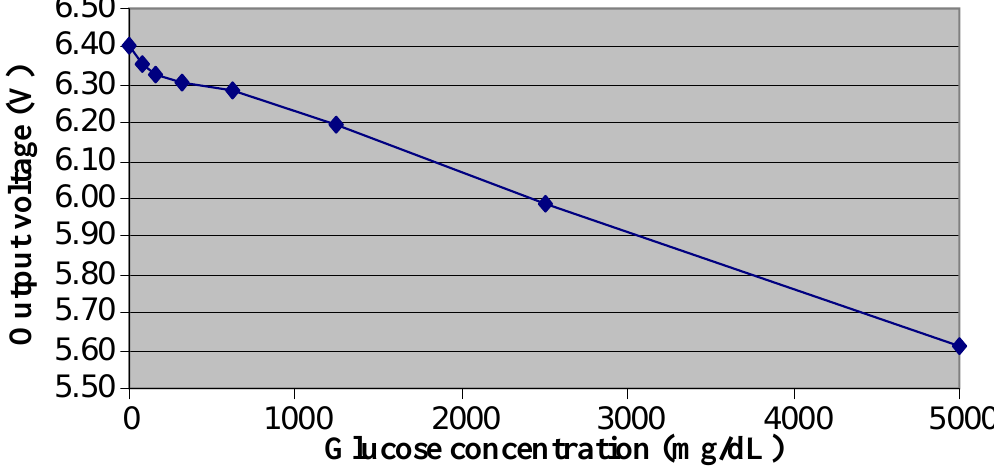
Figure 4. Output voltage of the electromagnetic sensor in relation to the glucose concentration of samples in the Ringer-lactate set, at room temperature and pump powered at 10